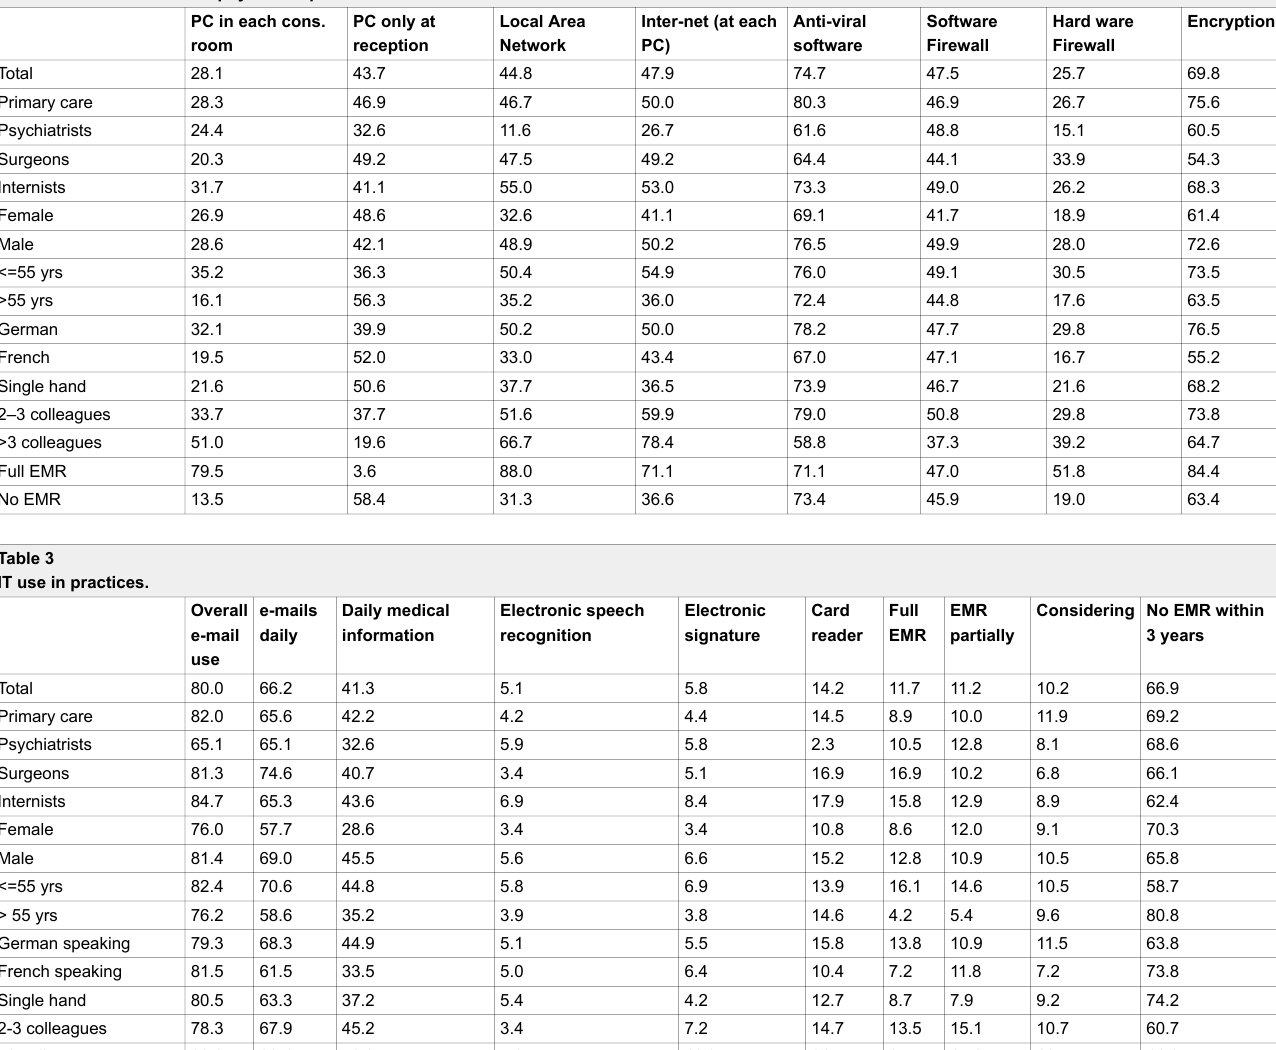
Table 2 IT – Infrastructure in Swiss physicians